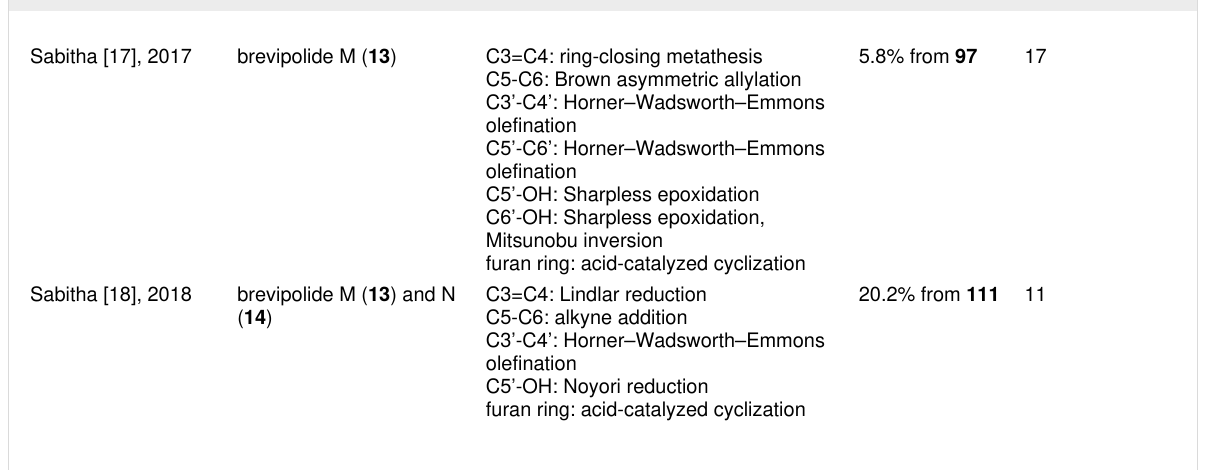
Table 4: Summary of the syntheses described in this review.